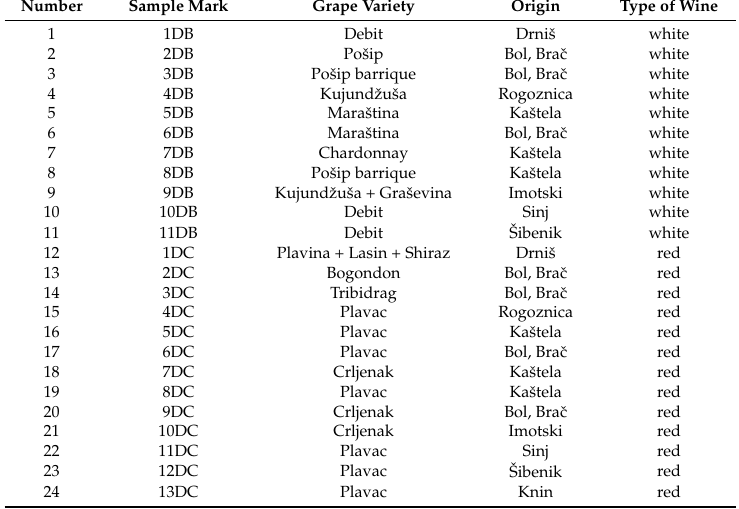
Table 1. The investigated red and white wine samples from Croatian coastal wine region of